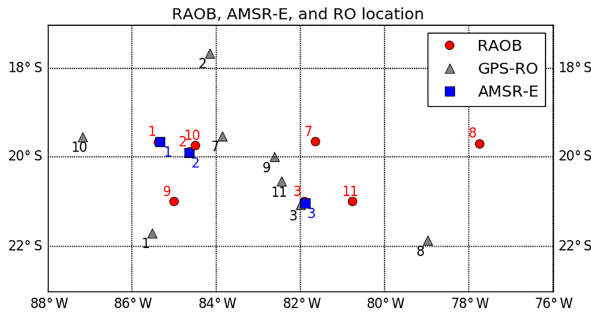
Figure 9. The map of the eight collocated RAOB and COSMIC GPS-RO measurements in the VOCALS campaign. Three AMSR- E measurement locations, which coincided with RAOB measure- ments in the first three cases, are shown in blue squares. The dis- tance between the RAOB (and AMSR-E) and the corresponding RO cases is 250km on average. The temporal difference for all eight cases is within